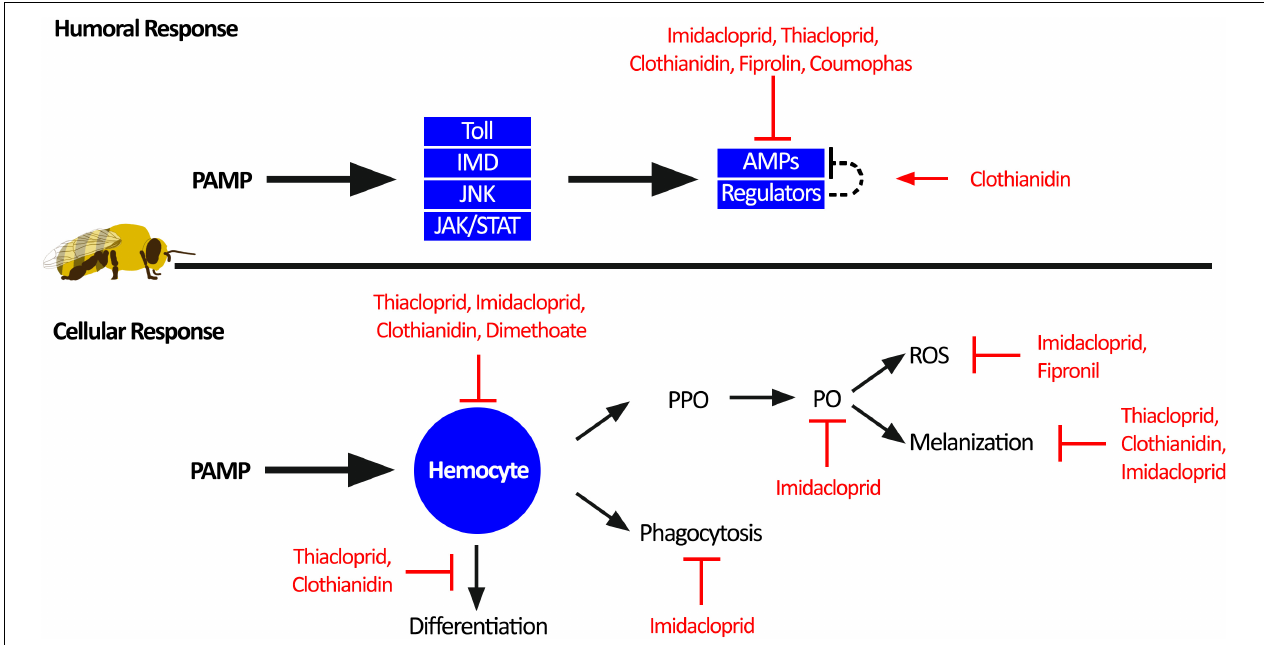
FIGURE 3 | Individual honey bee immunity impairment by pesticides. Honey bee immune response toward pathogen-associated molecular patterns (PAMPs) can be divided into humoral response and cellular response. The humoral response generates antimicrobial peptides (AMPs) through activation of the four immune pathways: Toll, immune deficiency pathway (IMD), c-Jun N-terminal kinase (JNK), and Janus kinase/signal transducers and activators of transcription (JAK/STAT). Sublethal pesticide exposure impairs the humoral immune response by reducing the production of AMPs. The cellular immune response is orchestrated through hemocyte function. Hemocytes can facilitate melanization of pathogens and wounds through activation of prophenoloxidase (PPO) to phenoloxidase (PO) and reactive oxygen species (ROS) as a by-product. In addition, hemocytes can phagocytosis and clear invading pathogens, as well as differentiation into other immune cells. Multiple aspects of the cellular immune response are impaired by sublethal pesticide exposure.